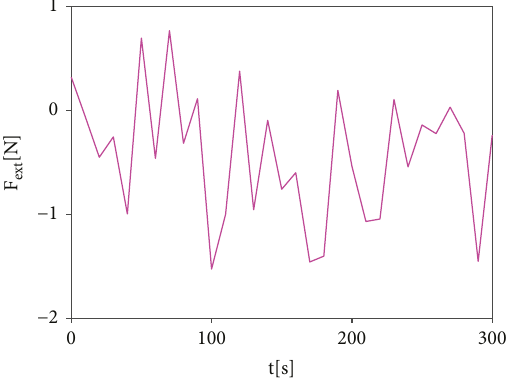
Figure 13: External